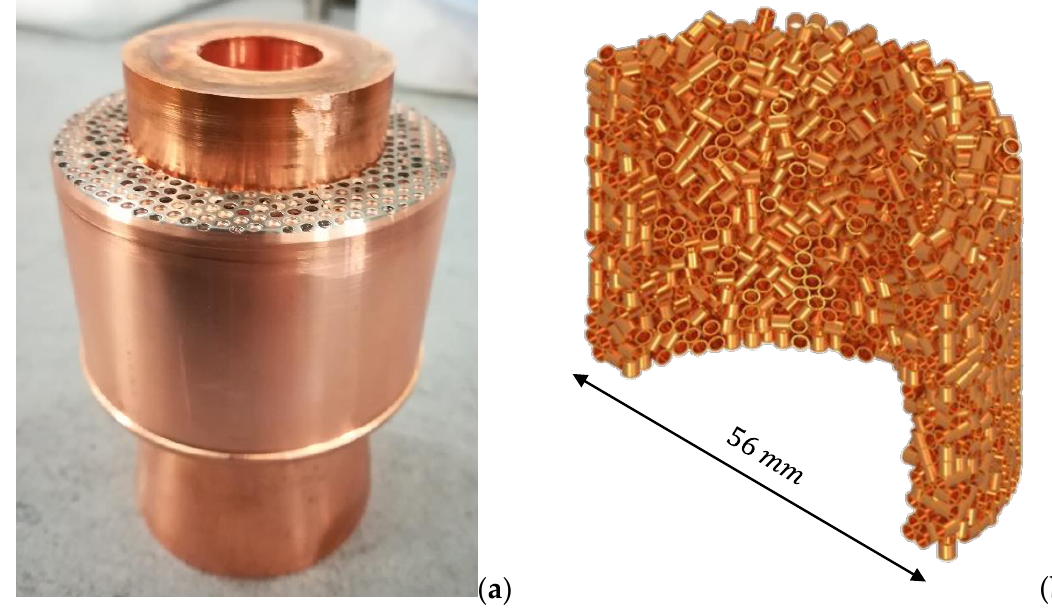
Figure 6. Cavity equipped with Raschig rings (RRs): ( a ) view of the ensemble constituted by the cavity, the water-stopper (WS), and the RRs, confined between the two by two containment grids; ( b ) zoomed-in view of the RR structure generated by discrete element model (DEM) simulation.